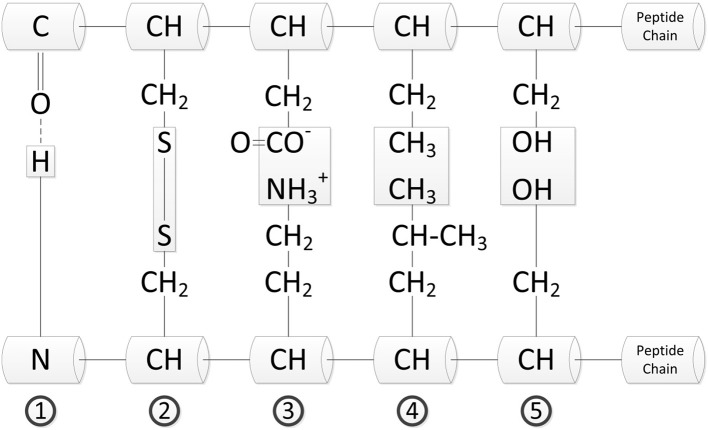
Structure stabilization between peptide chains (Bannwarth et al., 2007).